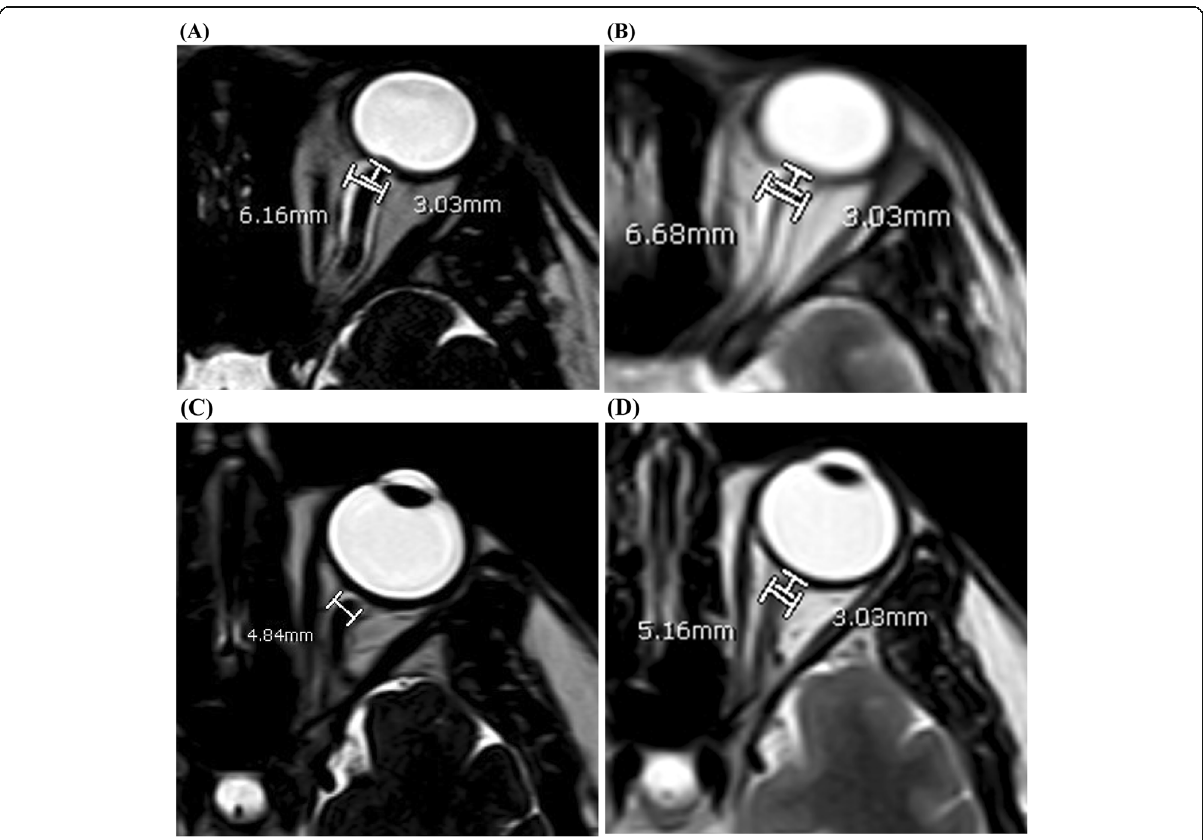
Fig. 2 3D DRIVE and T2 WI sequences show ONSD measured 3 mm behind eye globe. a , b 3D DRIVE and T2 WI sequences in a 35-year-old female patient with a diagnosis of IIH showing high ONSD measuring 6.16 mm in 3D DRIVE and 6.68 in T2 WI sequence. c , d 3D DRIVE and T2 WI sequences in 38 years female volunteer with normal ONSD measuring 4.84 mm in 3D DRIVE and 5.16 in T2 WI sequence